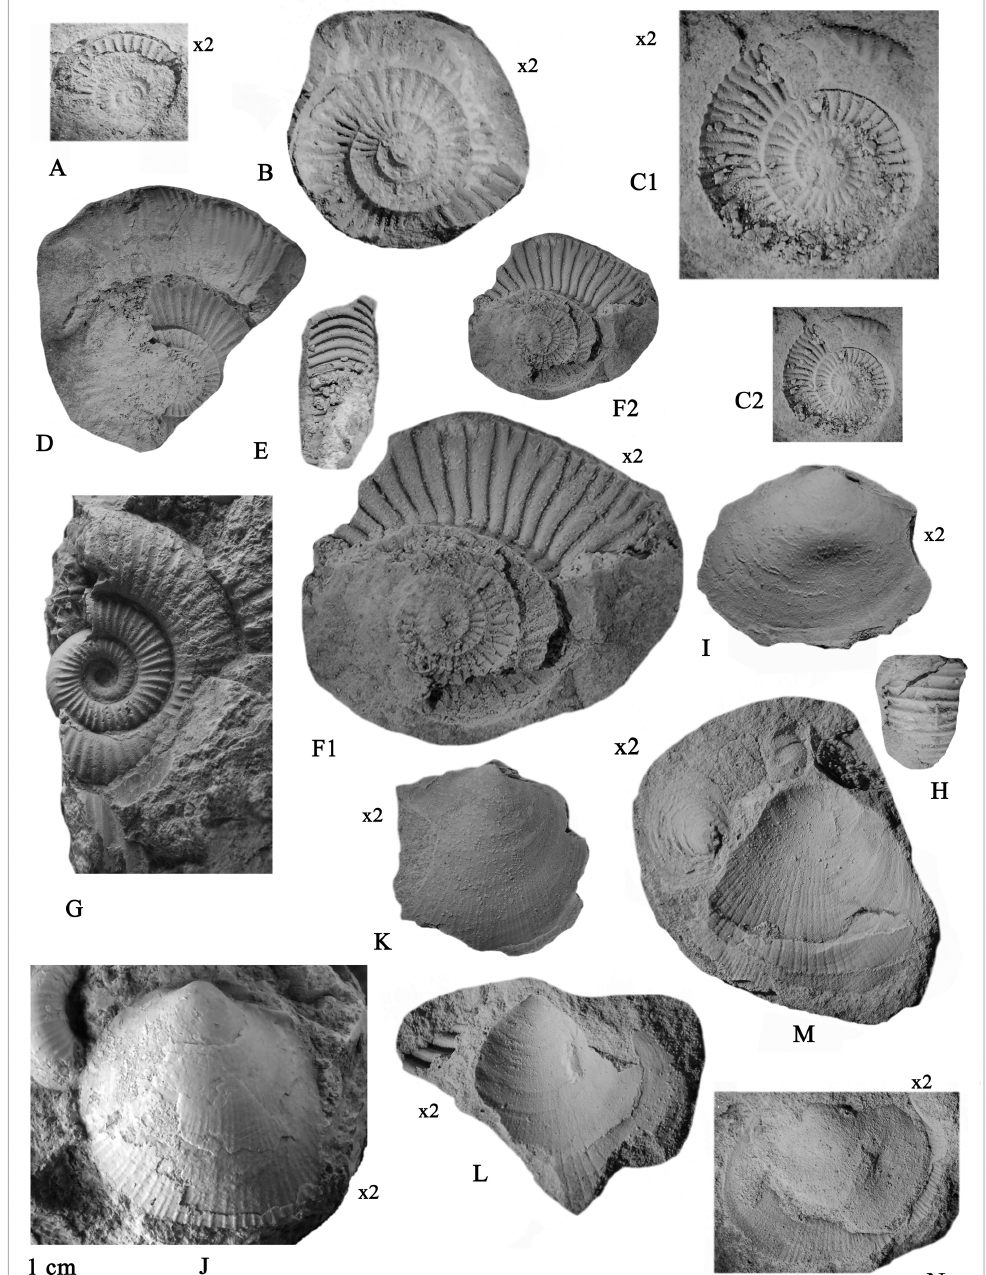
Figure 4. Lower Toarcian (Commune zone, kopiki horizon) dactylioceratid ammonites and oxytomid bivalves. Scale